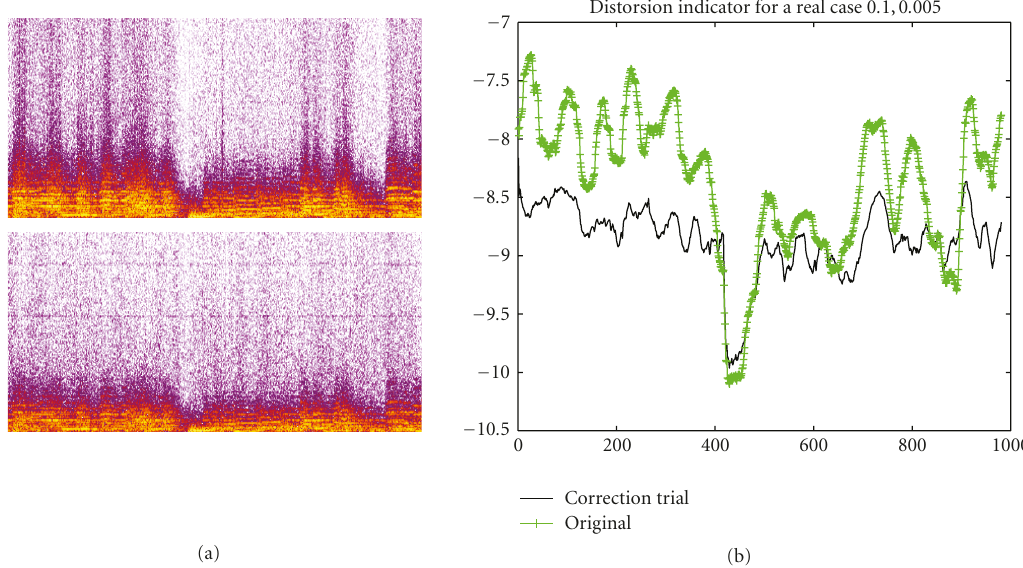
Figure 24: Top left: spectrogram of real soundtrack (“L’acrobate,” 5 seconds), grabbed by our scanner and converted to sound. Bottom left: spectrogram of the same sample after correction. Notice the noise level for real soundtracks (here no dust removal was performed). Right: for this sound sample, the HD-indicator is plotted in green before correction and in black after correction.